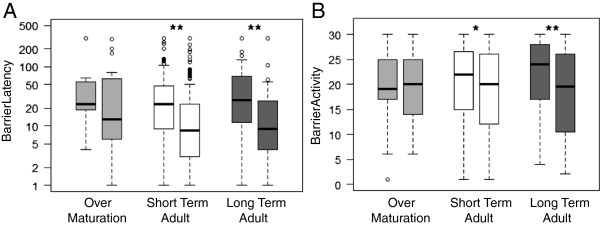
Comparison between first and second barrier-test within experimental groups of common voles. A) Barrier Latency [sec], B) Barrier Activity [1-0-sampling]. Significant differences in Wilcoxon signed rank test were indicated by stars.